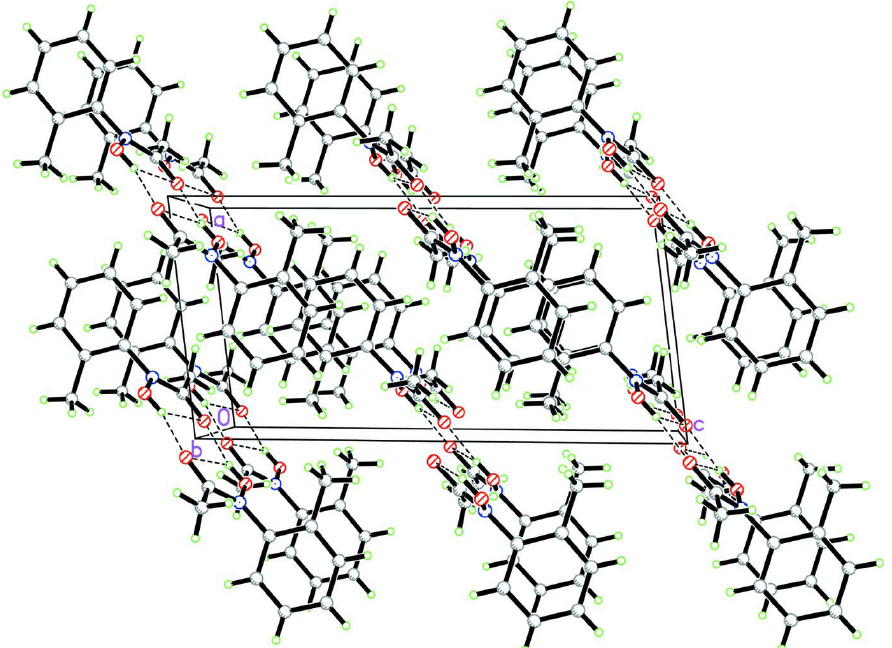
Figure 2 A packing diagram of (I). Hydrogen bonds are shown as dashed